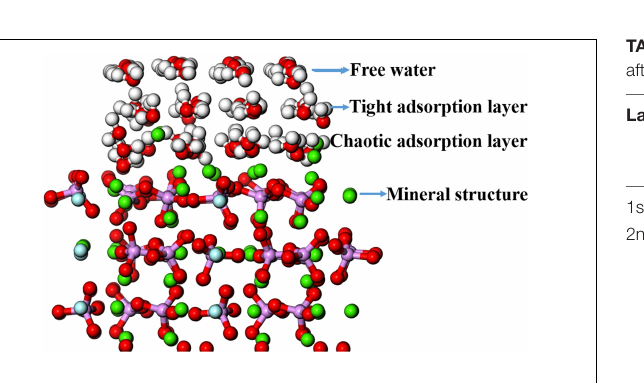
FIGURE 8 | Adsorption configuration of three layers of water molecules on the fluorapatite (001) surface.